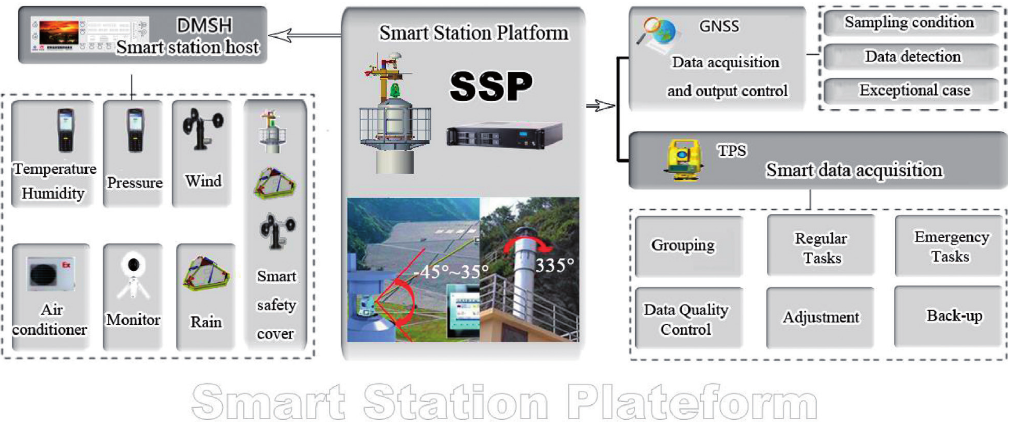
Figure 1: Framework of the integrated smart station platform.